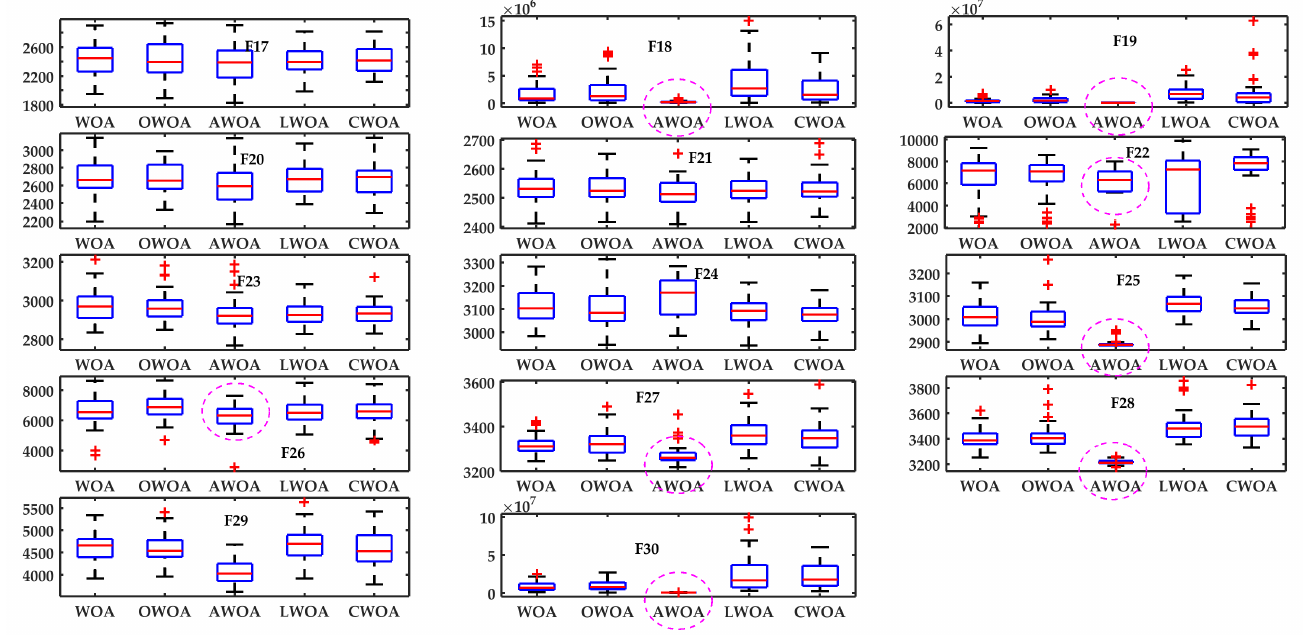
Figure 10. Boxplot analysis of the remaining 10D functions of Benchmark Suite